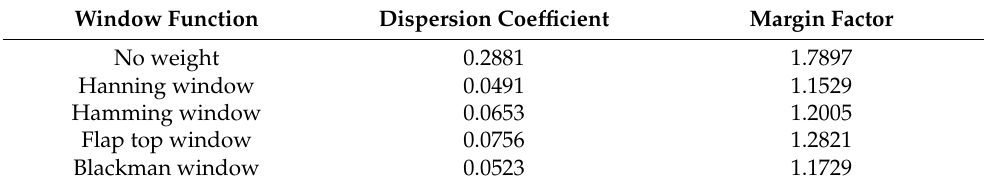
Figure 4. The signals of stator current amplitudes and inequality indicator with different window functions: ( a ) no weight, ( b ) Hanning window, ( c ) Hamming window, ( d ) Flap Top window, ( e ) Blackman window. Table 3. Statistical indicators of inequality indicator with different window